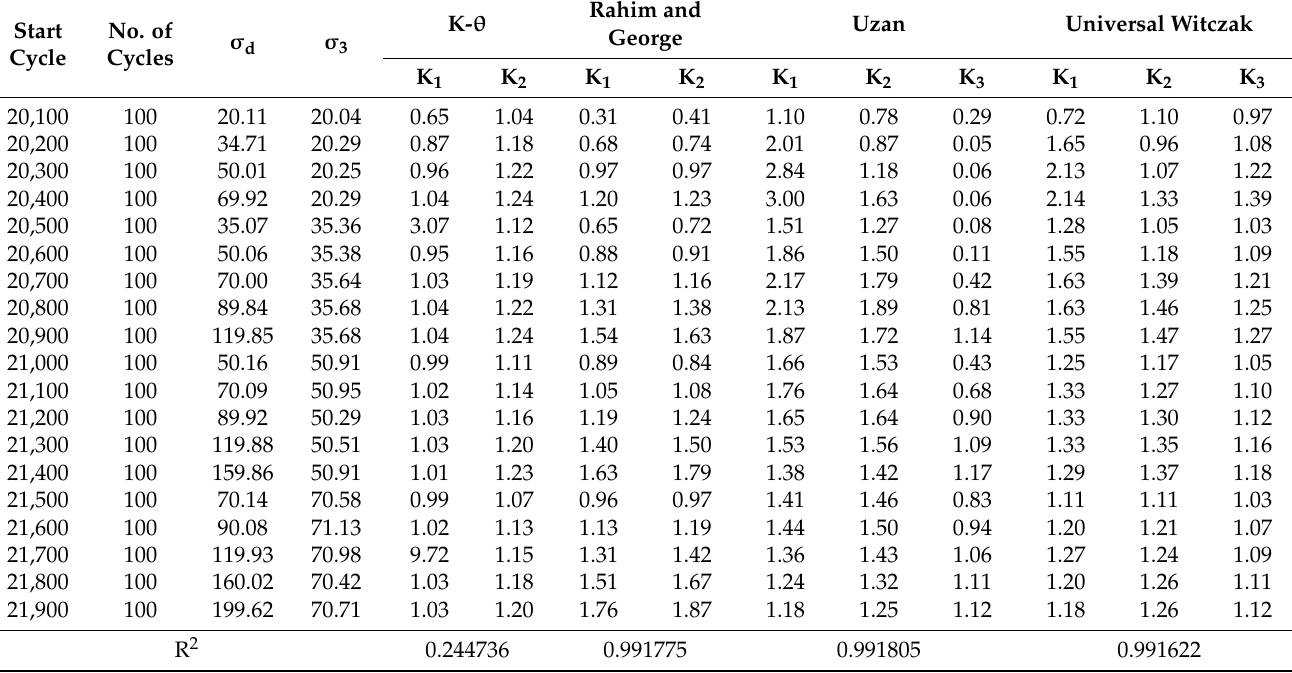
Table 5. Determination of models’ average regression coefficients for specimen